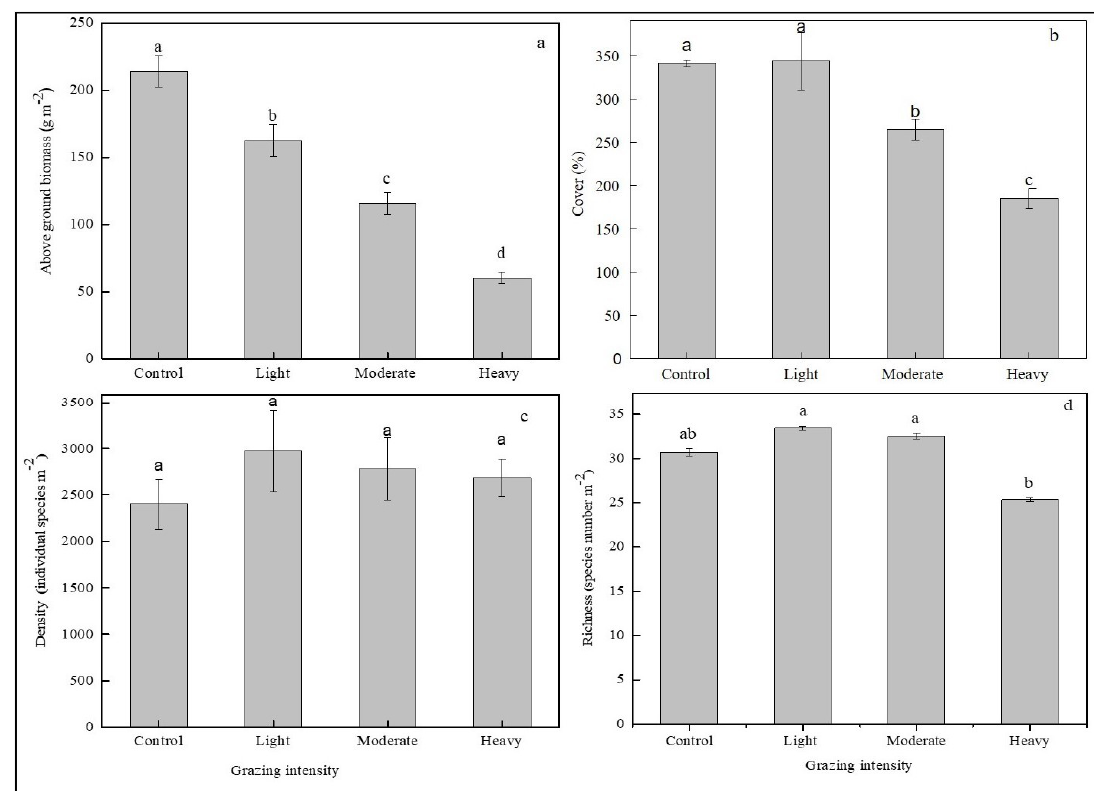
Figure 2. Grazing effect on community composition. Means (±SE) of ( a ) biomass, ( b ) cover, ( c ) species abundance and ( d ) species richness. Species richness refers to the number of species in the area. Species abundance refers to the number of individuals per sample of the eight plant functional groups under different grazing density. Different letters over the bars indicate significant differences at p < 0.05.